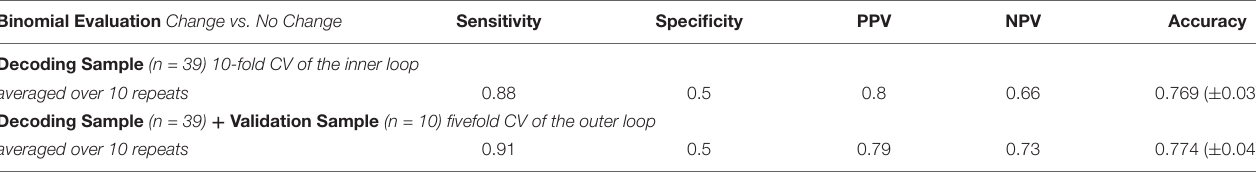
TABLE 5 | Binary evaluation of RF prediction